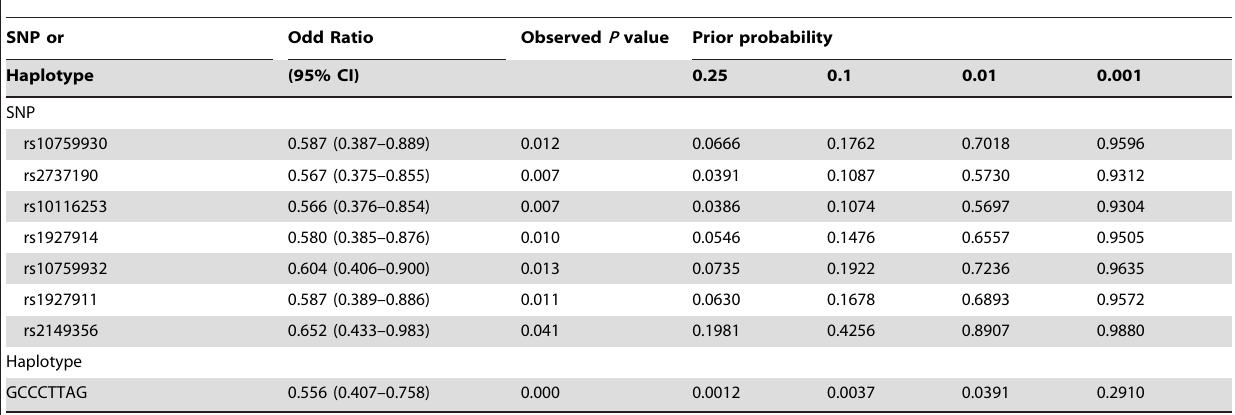
Table 5. FPRPs for the selected associations between genetic polymorphisms and hepatocellular carcinoma.